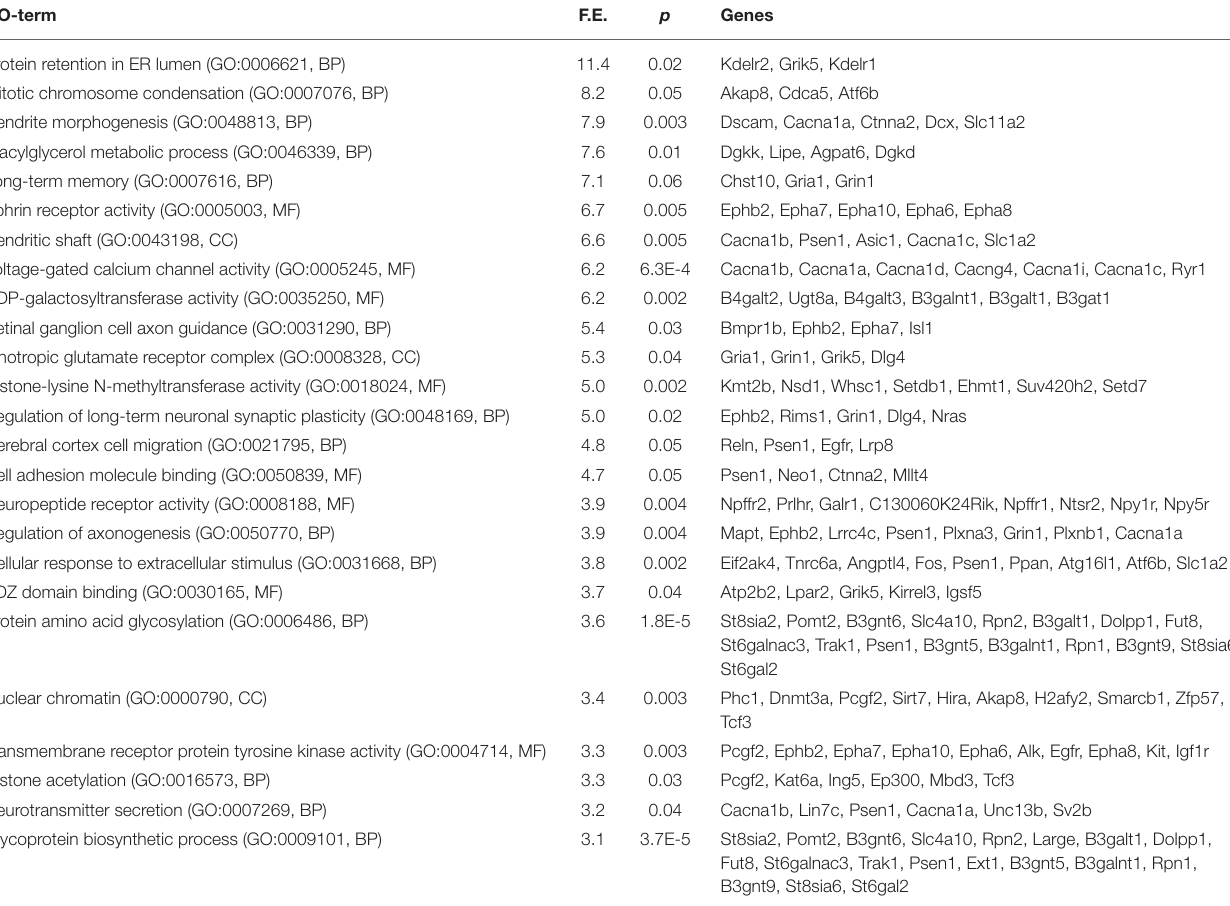
TABLE 4 | Most significantly enriched GO-terms from the genes up-regulated during maturation of the SCG neurons. GO-term F.E. p